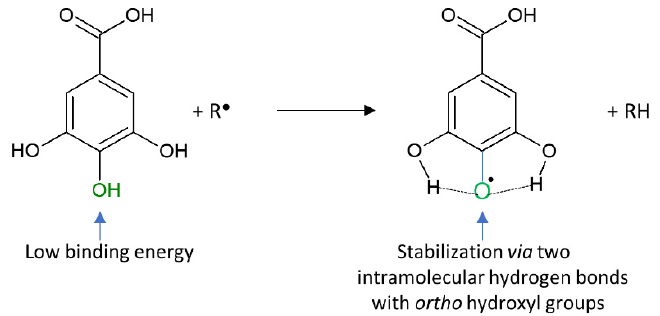
Figure 4. Gallic acid—free radical reaction and explanation of the stability of the obtained phenolic